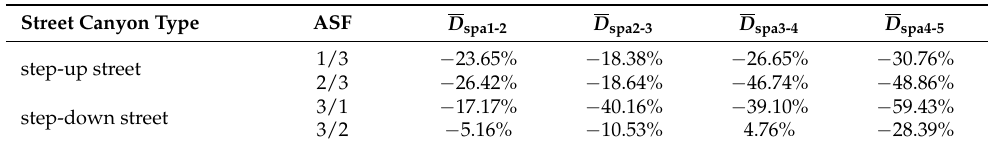
Table 1. Average airflow intensity percentage D i of pedestrian-level wind under different green belt schemes.